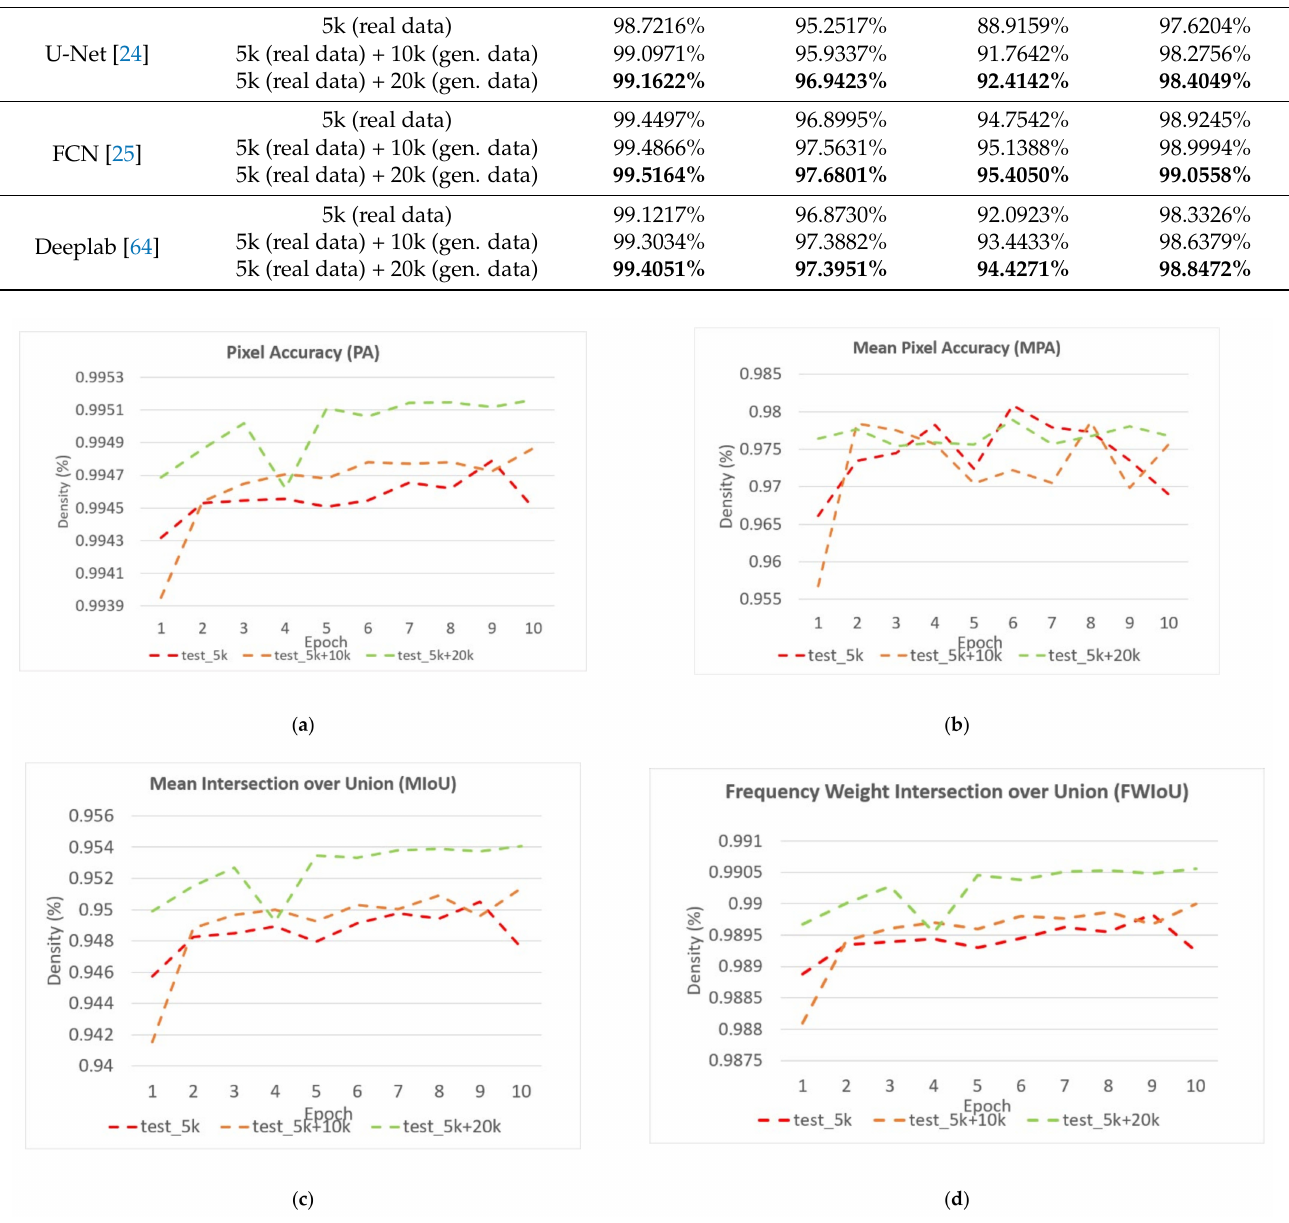
Figure 18. The performance of FCN network on customized dataset based on the value of: ( a ) Pixel Accuracy (PA); ( b ) Mean Pixel Accuracy (MPA); ( c ) Mean Intersection over Union (MIoU); ( d ) Frequency Weight IoU